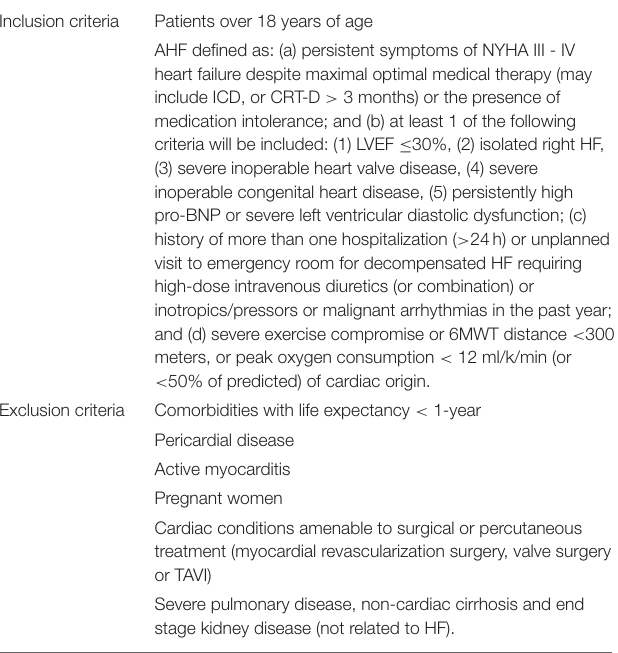
TABLE 1 | Selection criteria for participants to be included in the study. Inclusion criteria Patients over 18 years of